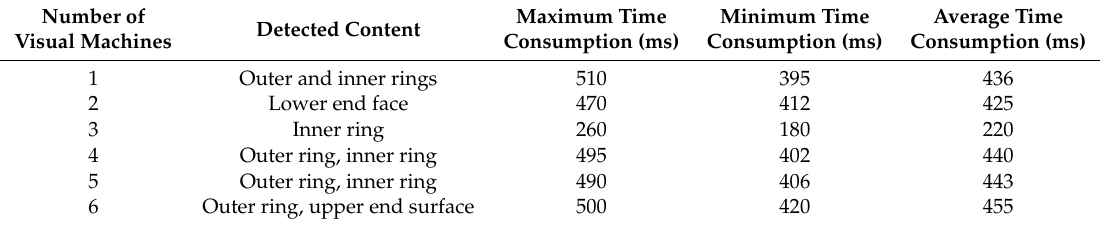
Table 1. Inspection time statistics of the vision machine.